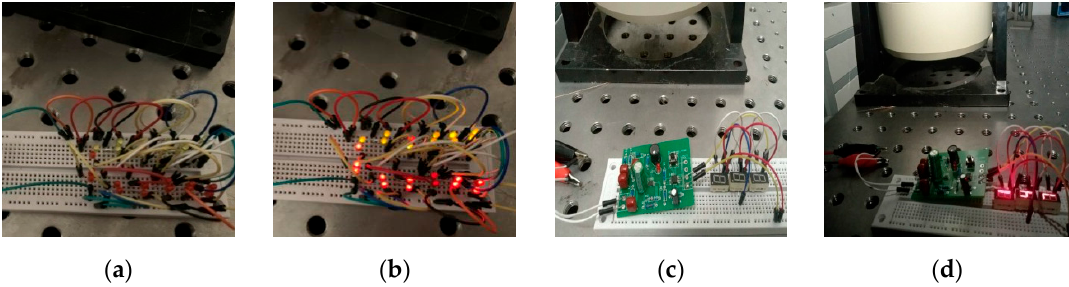
Figure 22. Photograph of a verification experiment for power generation e ff ect: in ( a ) and ( c ), harvester was not working; in ( b ) and ( d ), harvester was working and multi-LEDs and digital display tubes were lighted up.